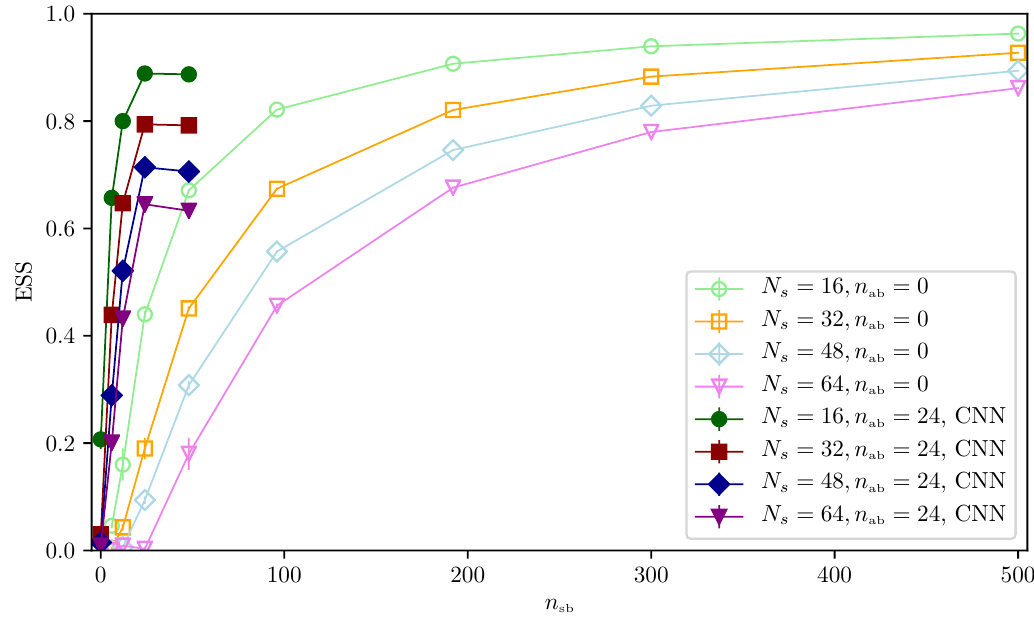
Figure 6 . Comparison of effective sample size for N t = 8 lattices between purely stochastic evolutions (light colors) and SNFs with CNNs and n ab = 24 (dark colors) as a function of n sb , at κ = 0 . 2 , λ = 0 . 022